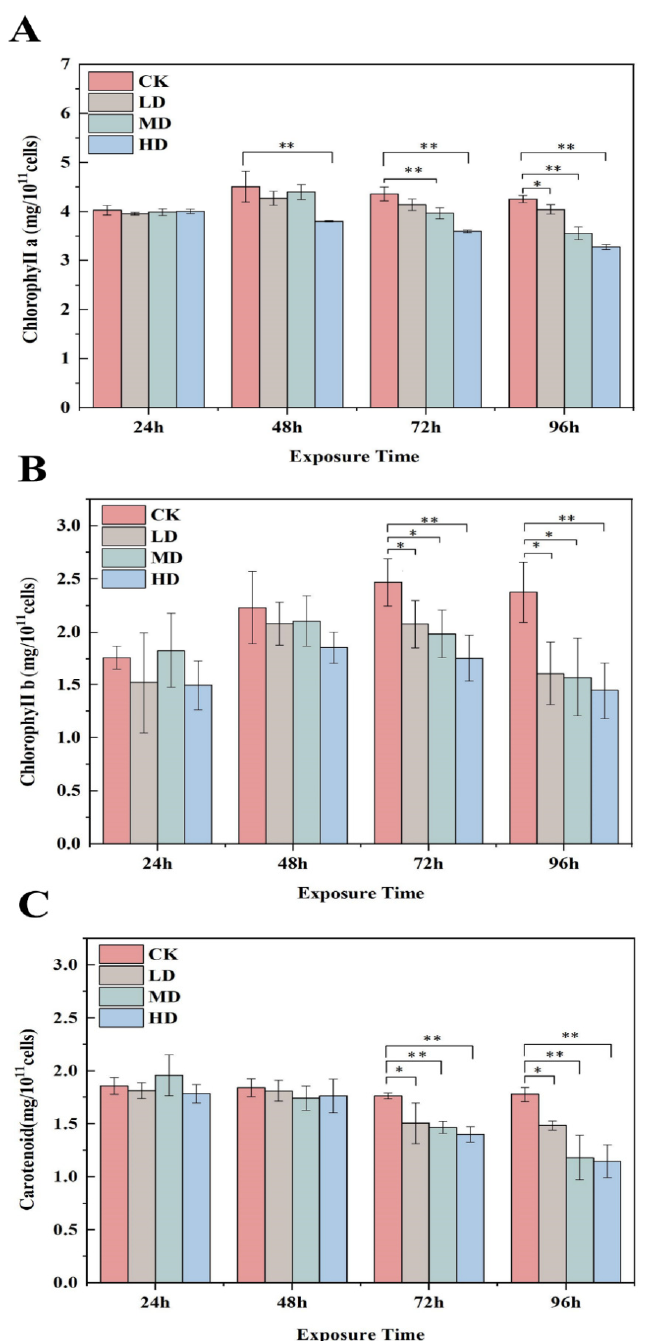
Figure 2. Effects of 17 α -EE 2 concentrations on C. pyrenoidosa chlorophyll a, b ( A , B ) and carotenoid ( C ) content within 96 h exposure. * and ** represent statistically significant differences with respect to the values of control cultures at p < 0.05 and at p < 0.01 levels, respectively. CK: control; LD: low dose; MD: moderate dose; HD: high dose. The effects of different concentrations of 17 α -EE 2 on the photosynthetic system of C.